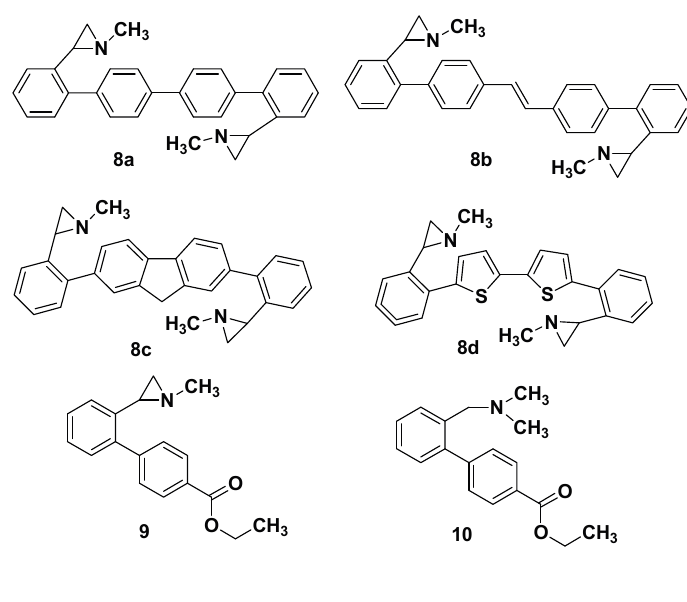
Figure 1. Other functionalized aziridines tested in this